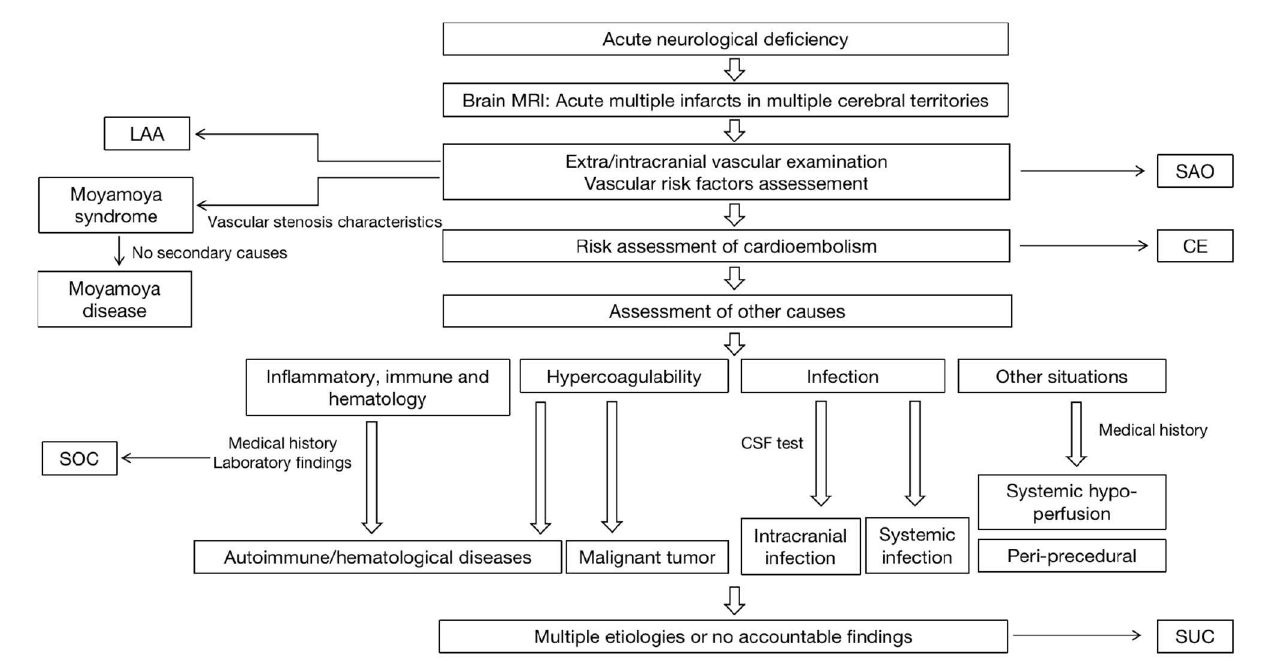
FIGURE2 The diagnostic algorithm of AMIMCT in clinical work. LAA, large artery atherosclerosis; SAO, small artery occlusion; CE, cardioembolism; SOC, stroke of other determined causes; SUC, stroke of undetermined causes.